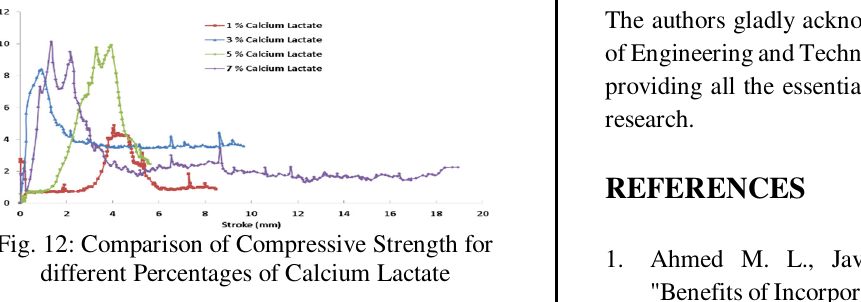
Fig. 12: Comparison of Compressive Strength for different Percentages of Calcium Lactate